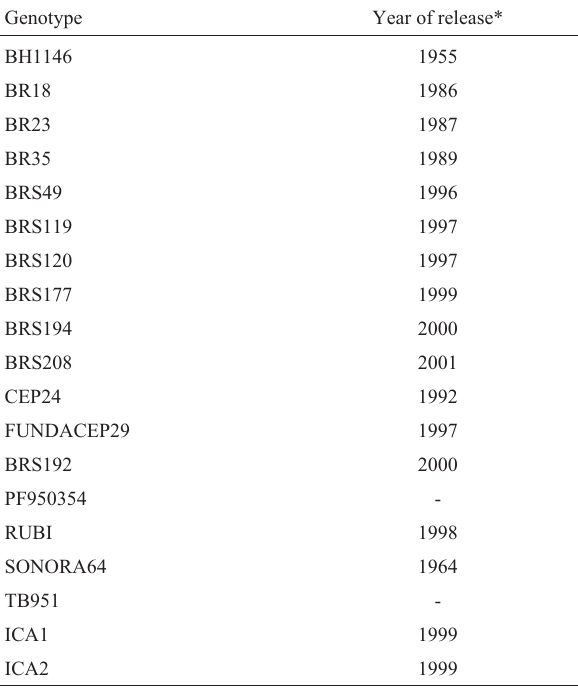
Table 1 - Wheat genotypes